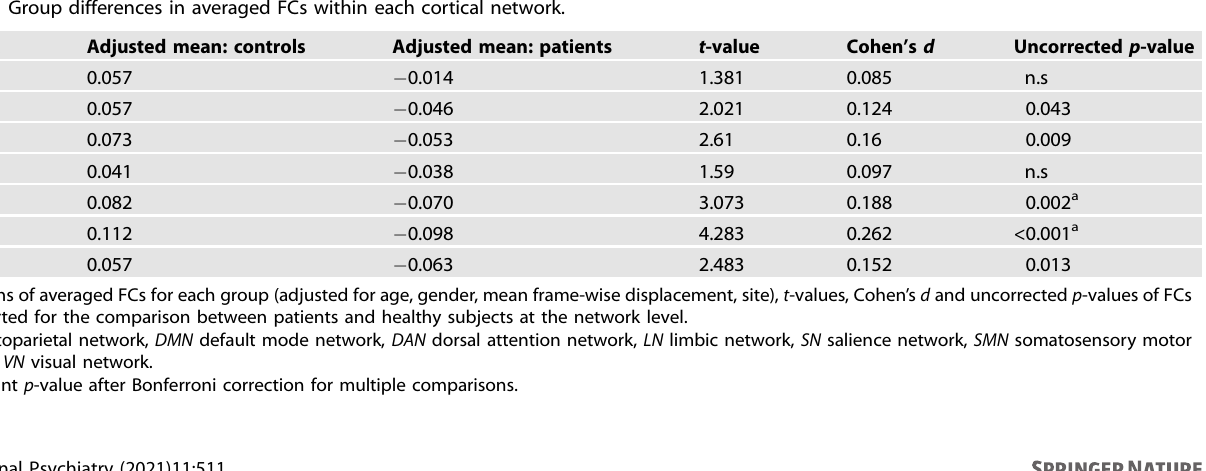
Table 2. Group differences in averaged FCs within each cortical network.